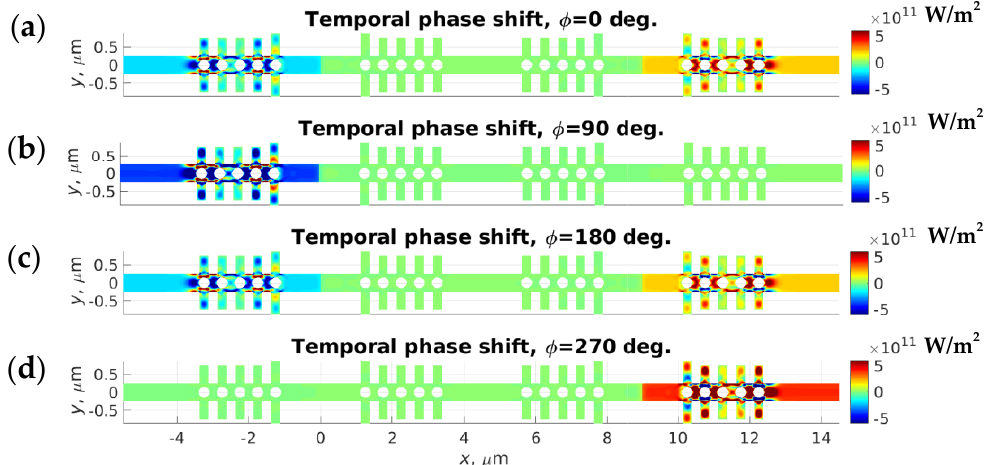
Figure 11. Spatial distribution of the x -component of the Poynting vector in a corrugated nanobeam with two cavities in the shape B with a straight nanobeam separation of D = 2 µ m for four temporal phase shifts: 0 ( a ), π /2 ( b ), π ( c ) and 3 π /2 ( d